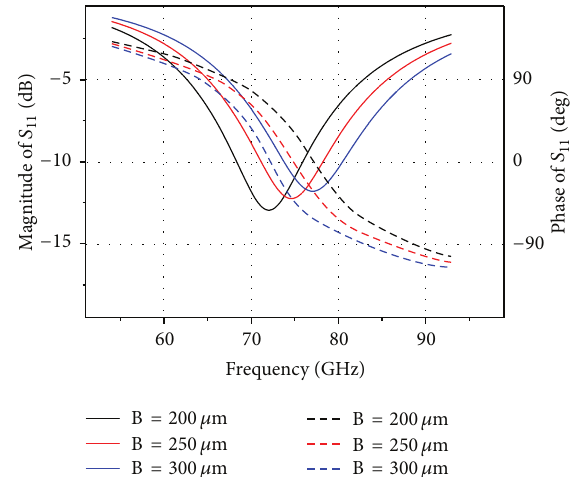
Figure 1: Geometrical configuration of a dogbone shape element.